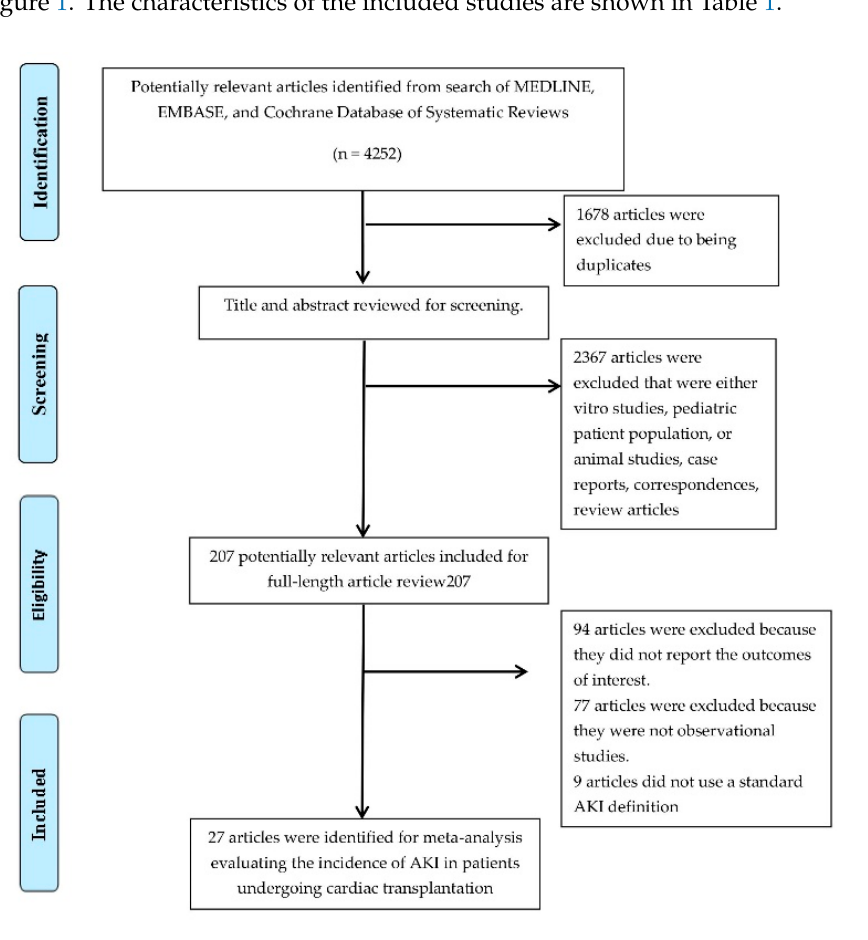
Figure 1. The flowchart for the systematic review.